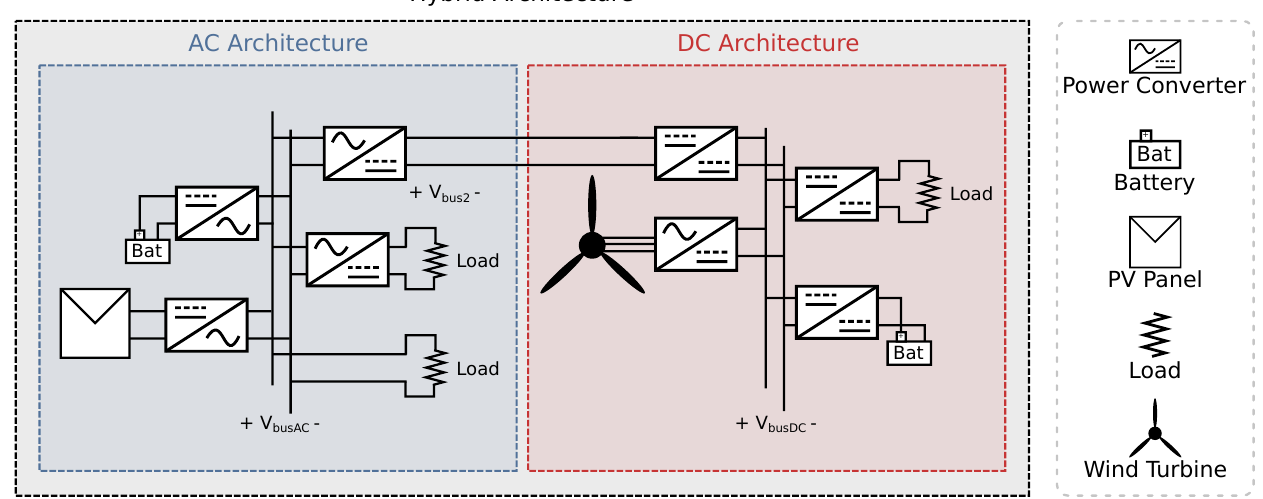
Figure 5. Representation of the different energy